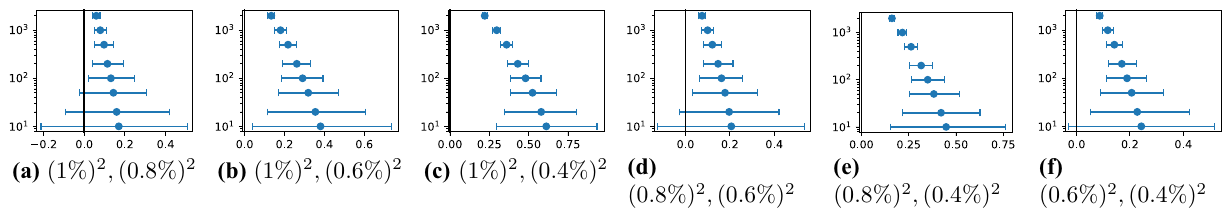
Fig. 6 The value gained by having some experimentation and measurement (E&M) capabilities ( x -axes, in percent) under dif- ferent capacity M ( y -axes, in log scale) in the case study on 6700 e-commerce experiments reported by Browne and Johnson [10] (see Sect. 7.1). In each plot, the dot represents the mean, and the error